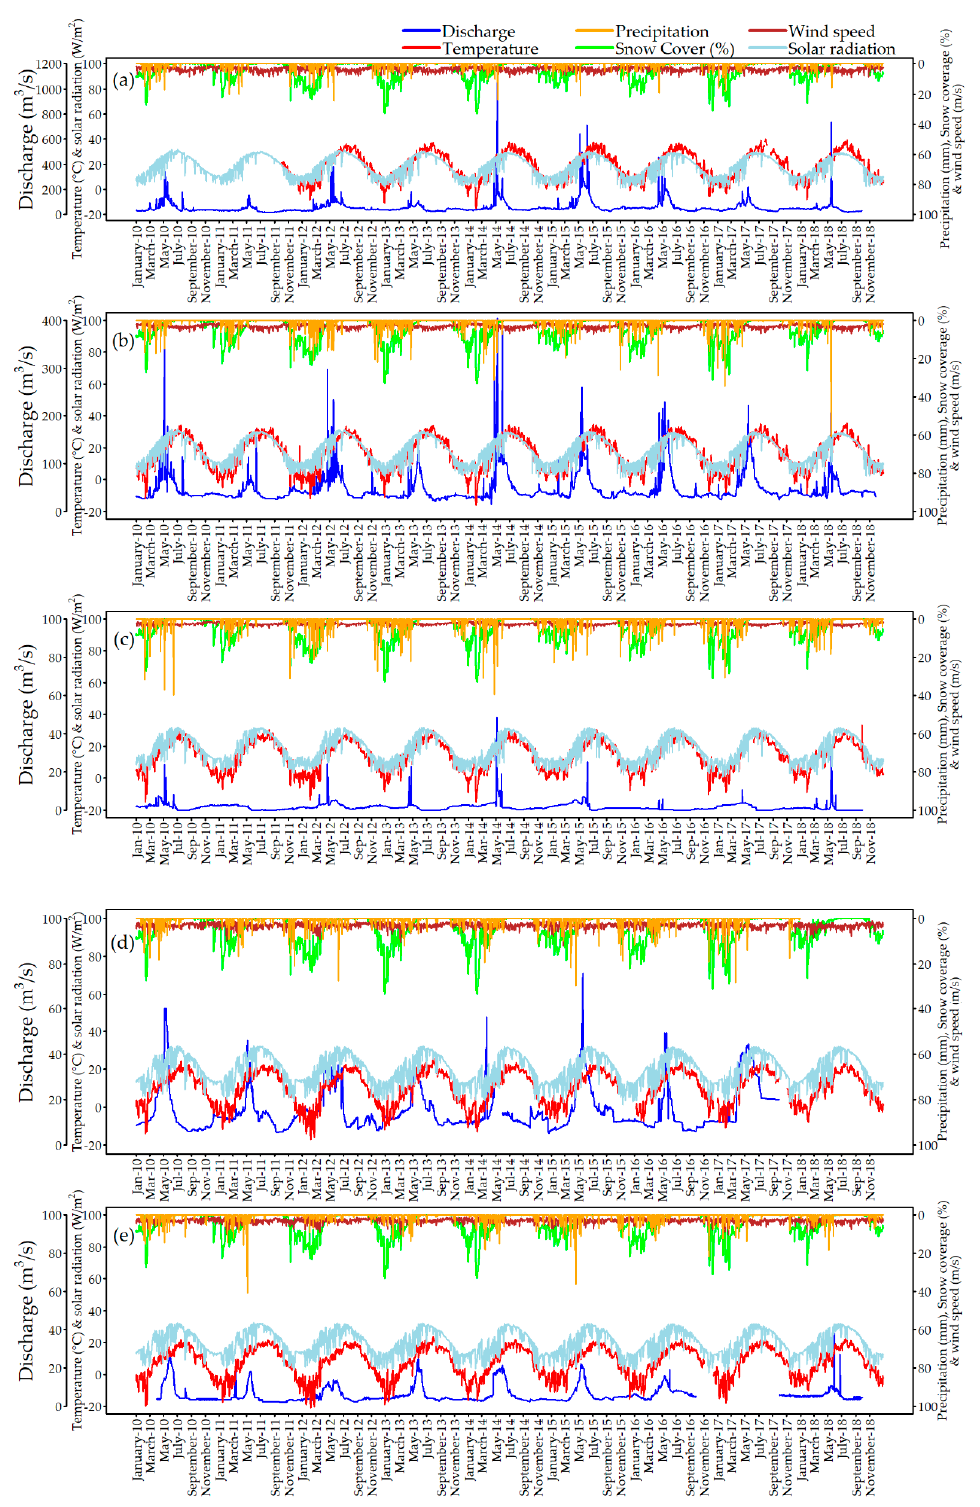
Figure A1. Time series of temperature, precipitation and discharge from gauging stations and snow cover area (%) based on the spatiotemporal combination of MODIS snow cover and NASA-PWER solar radiation and wind speed. ( a ) Rabat-i-